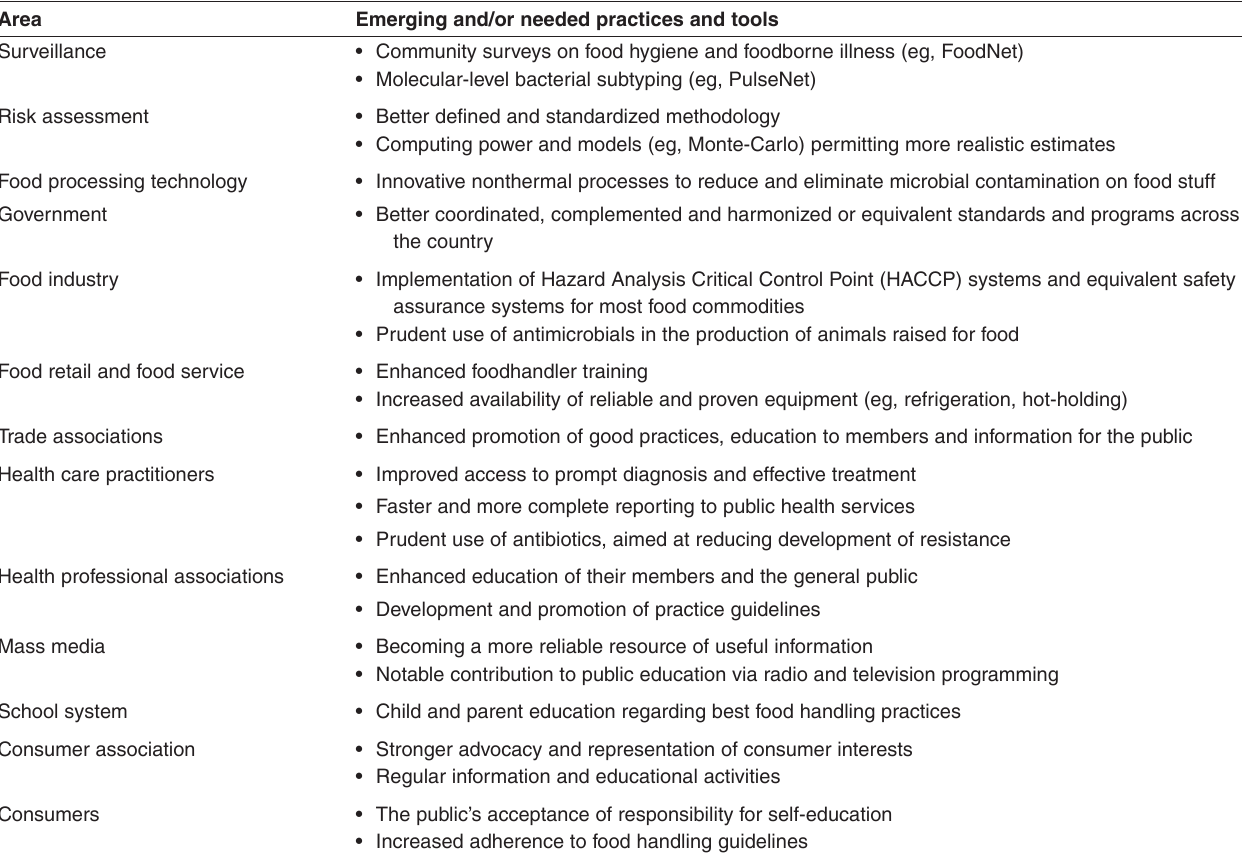
TABLE 3 A summary of the emerging and needed practices and tools aimed at further improving the food safety system Area Emerging and/or needed practices and